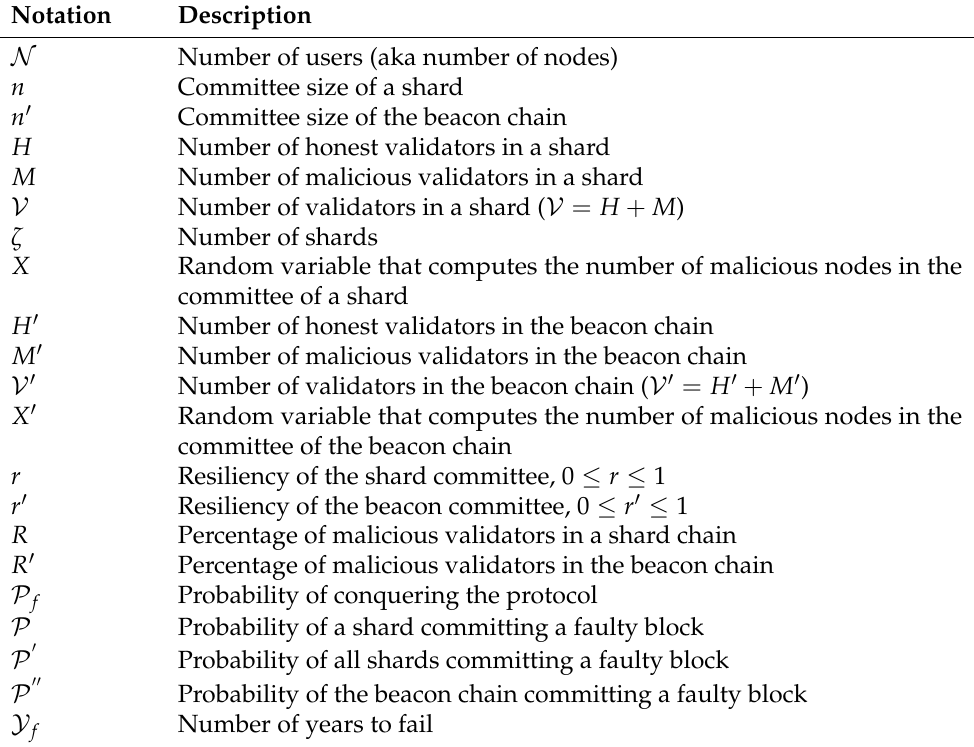
Table 2. Notations &